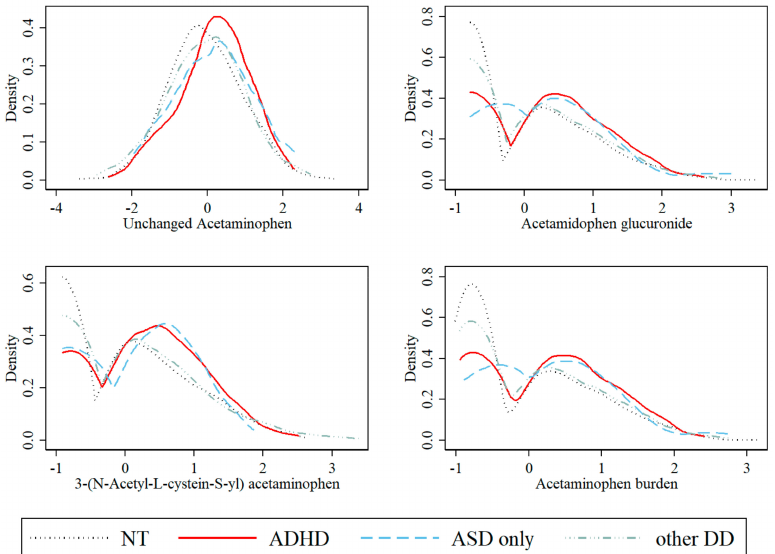
Figure 2. Comparison of the distributions of acetaminophen metabolites and acetaminophen burden by specific diagnosis groups. NT was defined as free of any developmental disorder diagnosis; ADHD was defined as any ADHD diagnosis; ASD only was defined as any ASD diagnosis without having an ADHD diagnosis; other DD was defined as any developmental disorder diagnosis other than ASD and